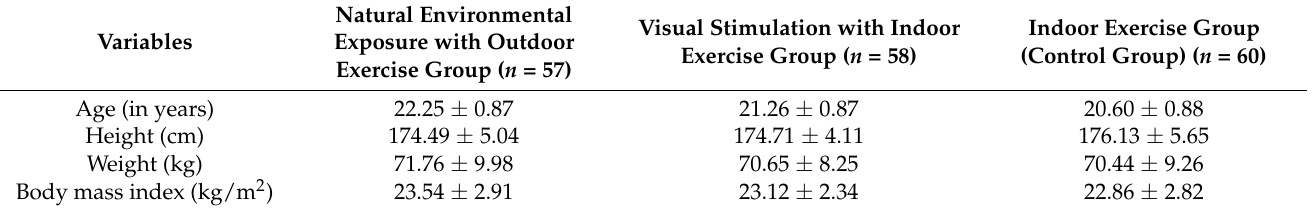
Table 1. Participant characteristics ( n =